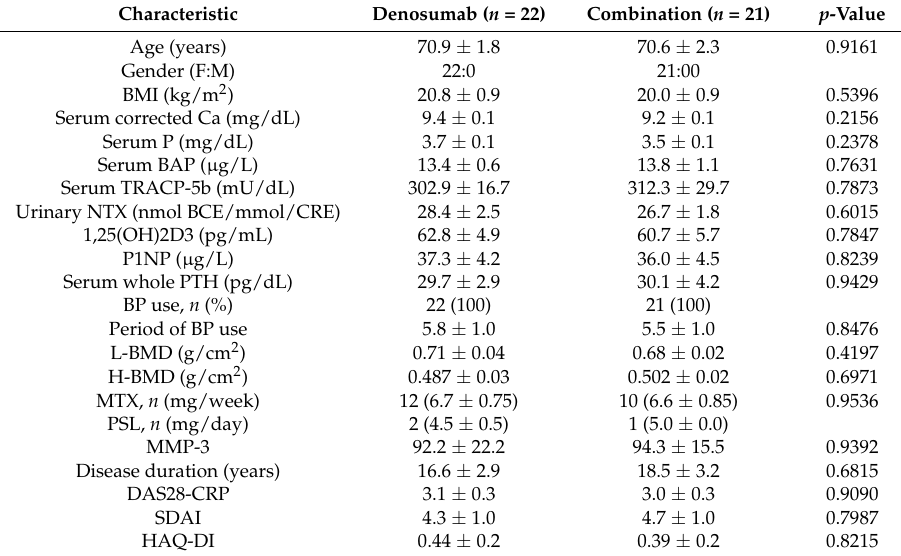
Table 1. Patient characteristics at baseline. Data are expressed as mean ± standard